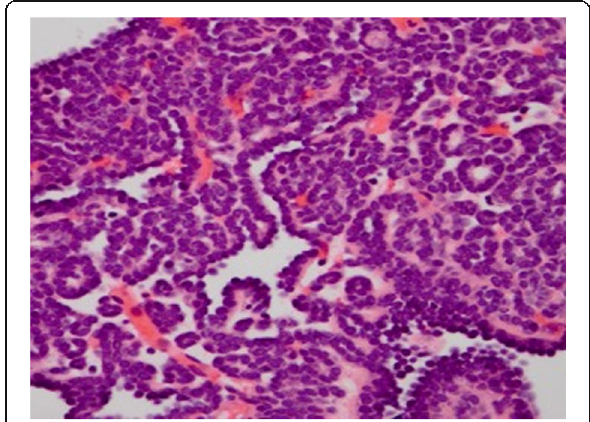
Fig. 2 Hematoxylin and eosin photomicrograph of BRAF wild type case, showing classic features of renal metanephric adenoma. Small cells with a high nuclear to cytoplasmic ratio form small tubules, rudimentary intraluminal buds and sheets